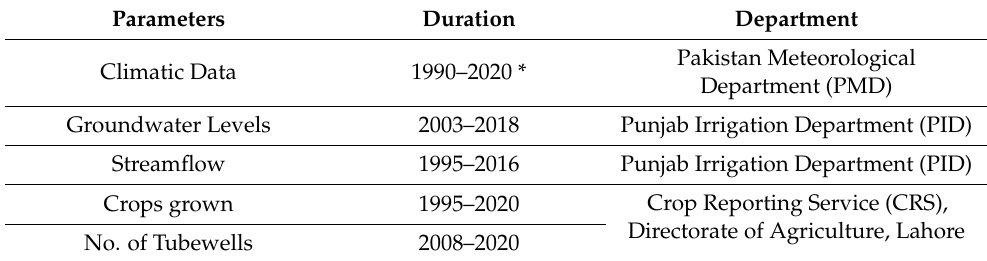
Table 2. Data collected from various